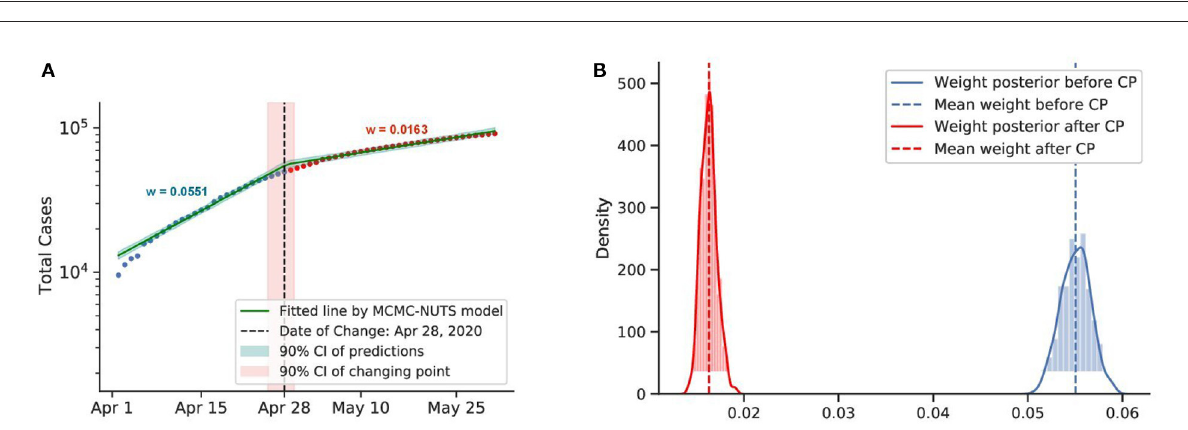
FIGURE7 Posterior for Canada. Canada recorded a total of more than 10,000 cases up to early April. The government imposed various restrictions in March-April (72) and reduced the transmission rate from 0.0551 to 0.0163. The change-point point was around April 28, 2020. (A) Fitted graph for Canada with change-point on April 28, 2020. (B) Posterior distribution of weights (transmission rate) before and after change-point.